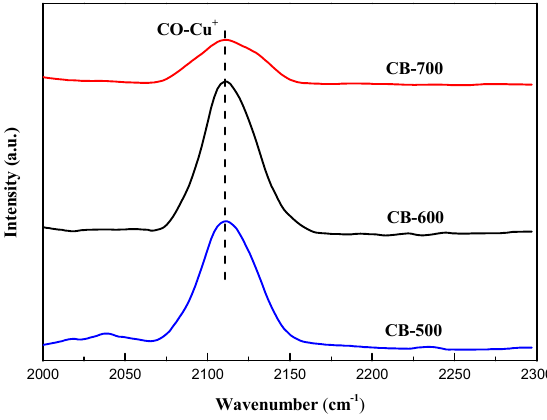
Figure 8. CO-IR spectra of used CuO-Bi 2 O 3 catalysts.